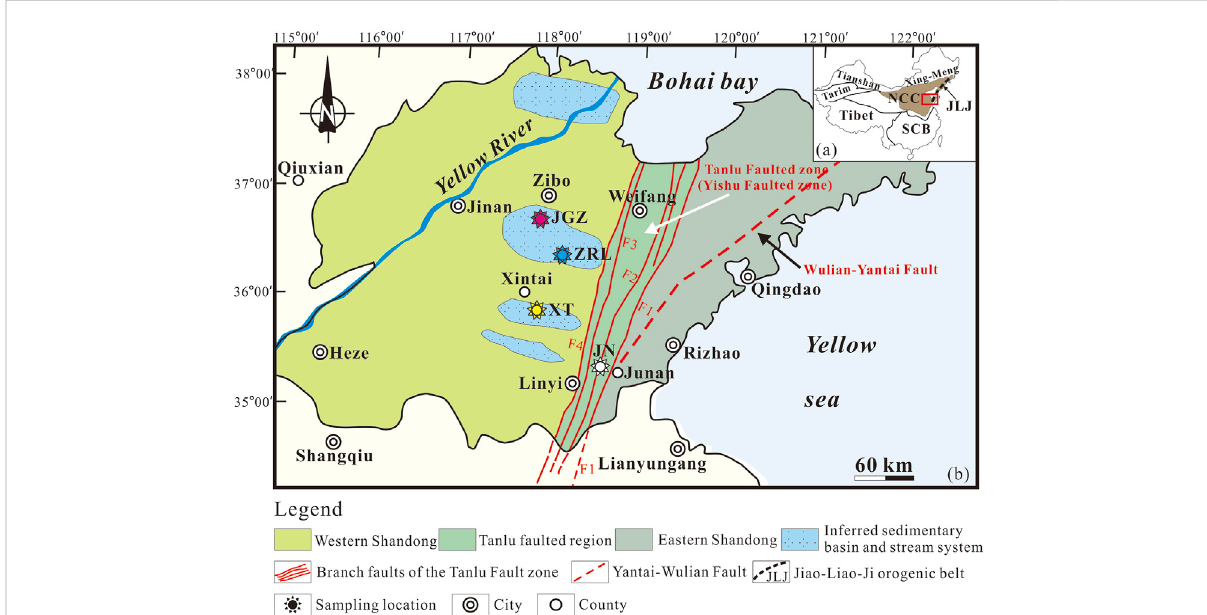
2008andLietal.,2010).F1toF4representingfourbranchfaultsoftheTanluFaultzone.InferredMiddle-LateJurassicsedimentarybasinandstream system are after Xu and Li (2015). JLJ=Jiao-Liao-Ji orogenic belt; NCC=North China Craton; SCB=South China